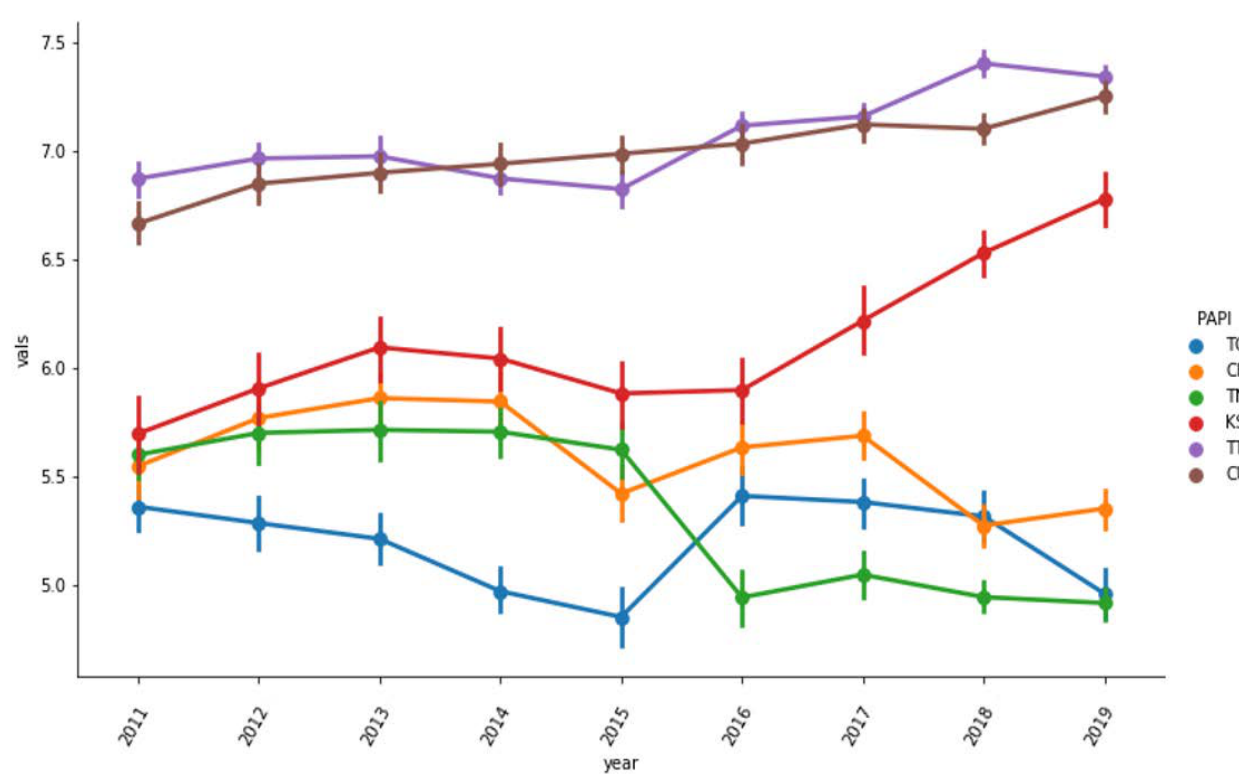
Figure 1. The change in the quality of public administration in the period 2011–2019.